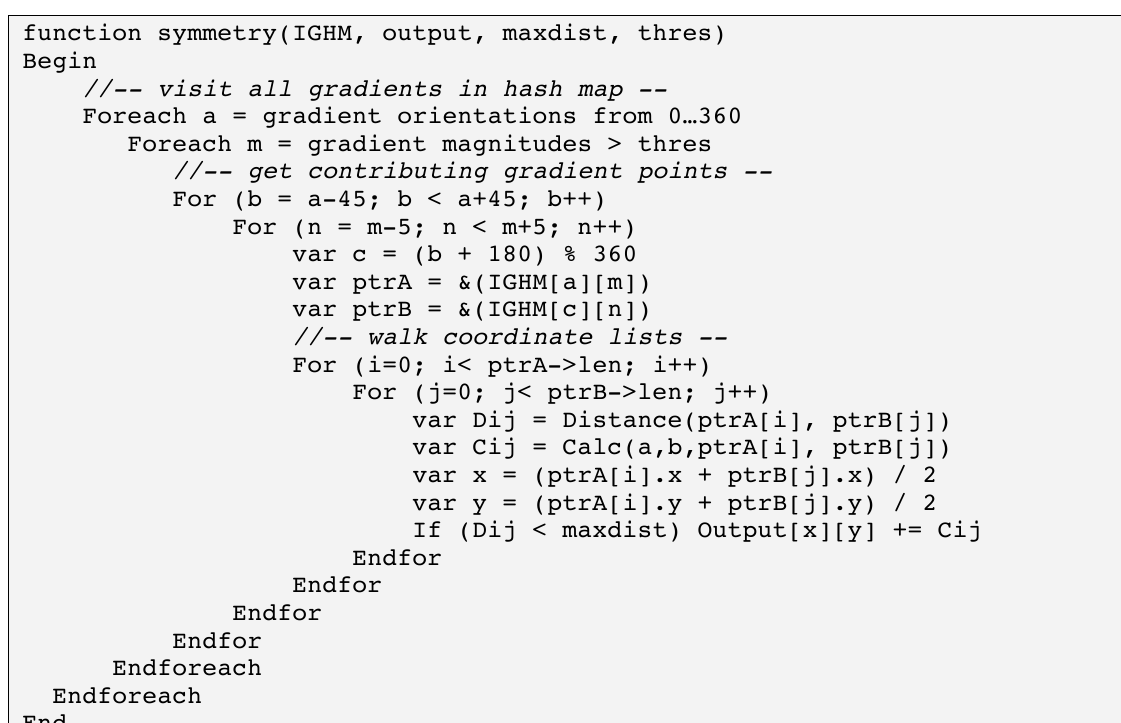
Listing 1. Basic Symmetry Detection Algorithm